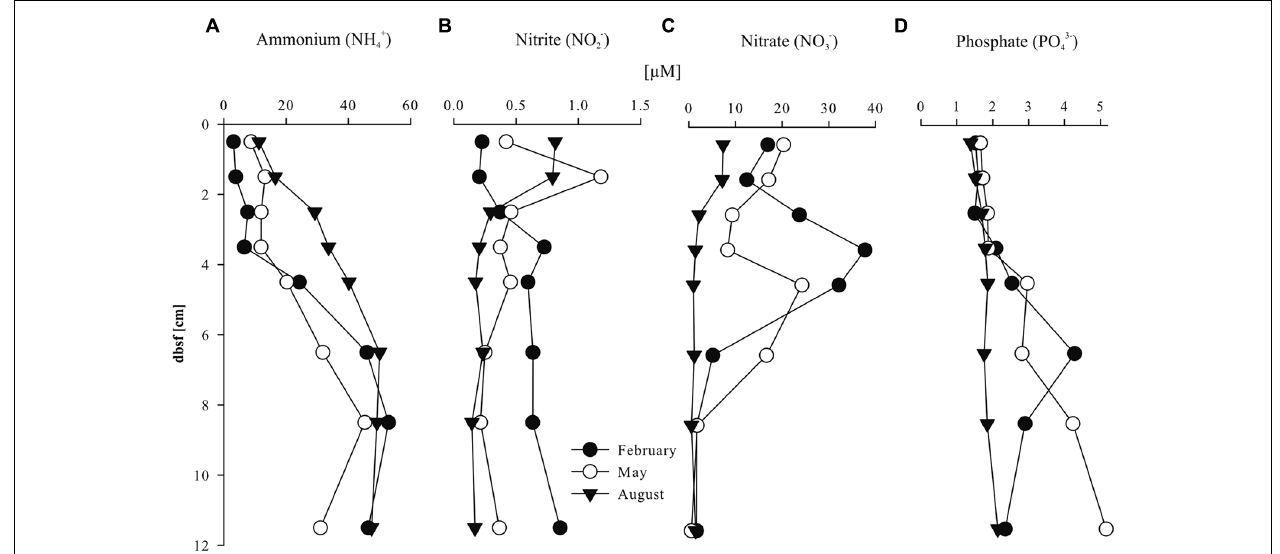
FIGURE 1 | Sediment pore water nutrients: (A) NH 4 + ; (B) NO 2 − ; (C) NO 3 − and (D) PO 43 + ( μ M) with sediment depth (cm) below sea floor